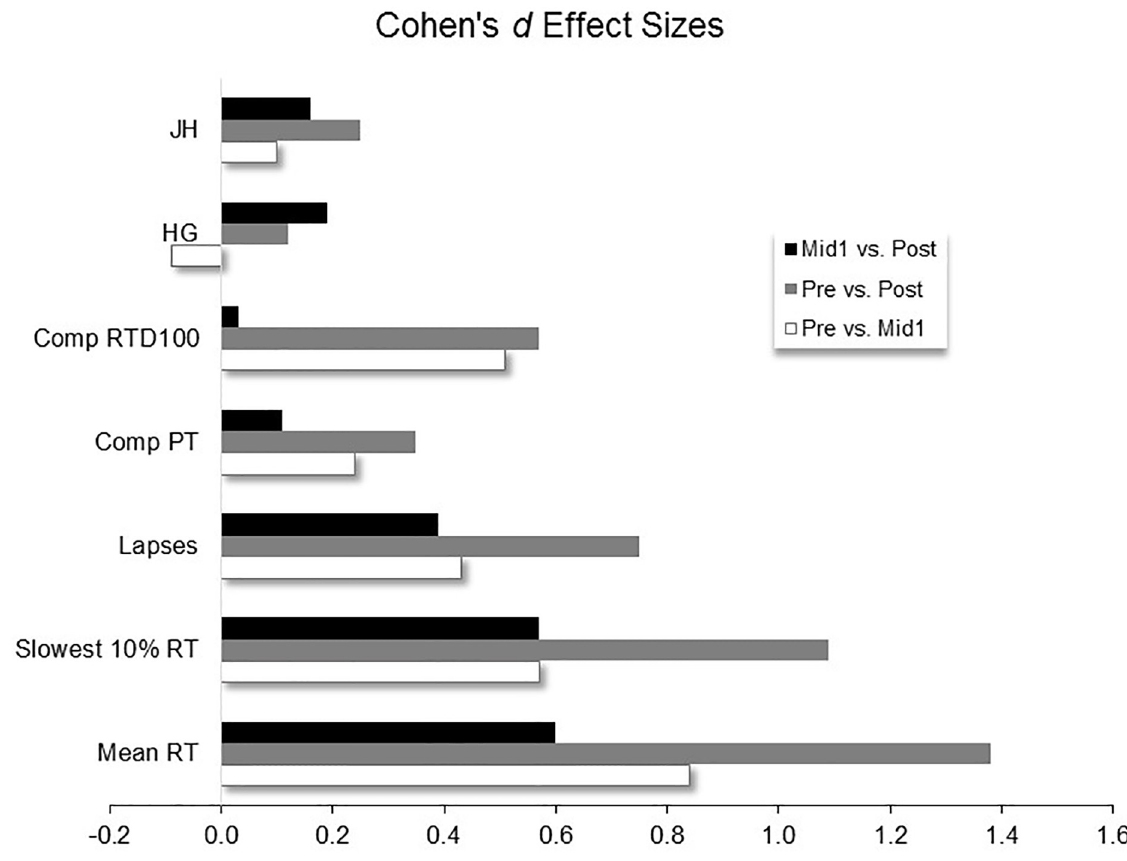
Fig 4. Cohen’s d effect sizes comparing time trial mean differences on primary outcome measures before (Pre), after one 12 hour work shift (Mid1), and at the end (Post) of the three day work shift schedule. JH = Jump Height; HG = Hand Grip; Comp = Composite score of knee extensors and flexors muscle groups; PT = Peak Torque; RTD100 = Rate of Torque Development at 100 ms; RT = Reaction Time. Note, positive effect size values indicate poorer performance on each variable when compared to the earlier time trial (e.g., reduced jump height, composite peak torque etc. or increased reaction times, lapses